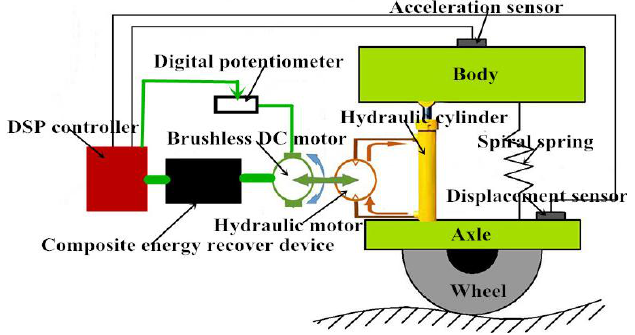
Figure 1. The structure of the semi-active energy regenerative suspension with an electro-hydraulic actuator (EHA). DC: direct current.